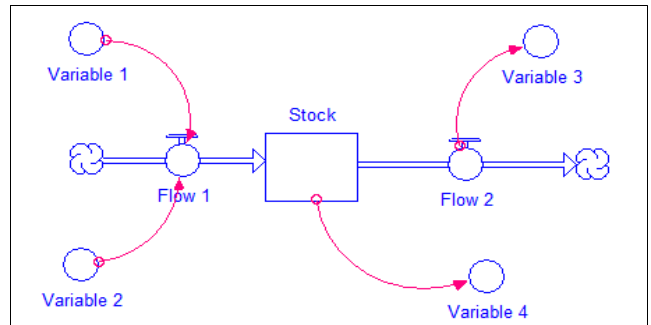
Fig. 1. The minimal stock-and-flow diagram in System Dynamics